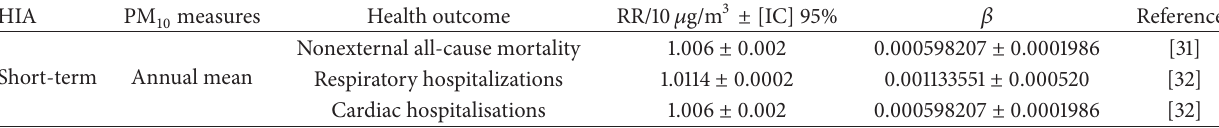
Table taken from Aphekom City Report Marseilles .